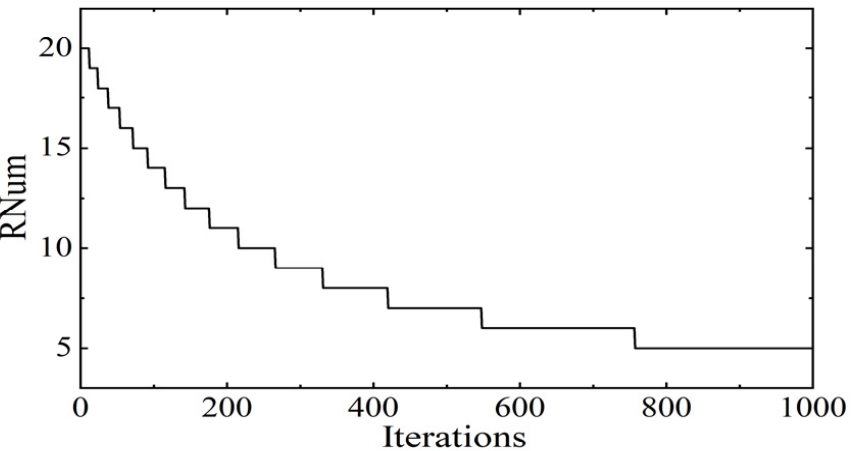
Figure 3. Constrained rooster number curve.